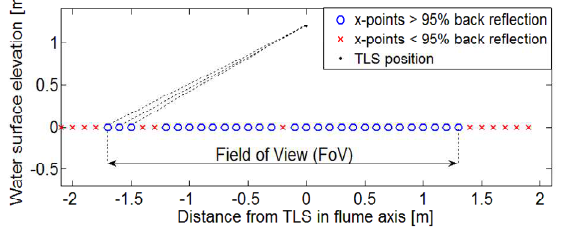
Figure 5. Definition 95% Field of View (FoV)